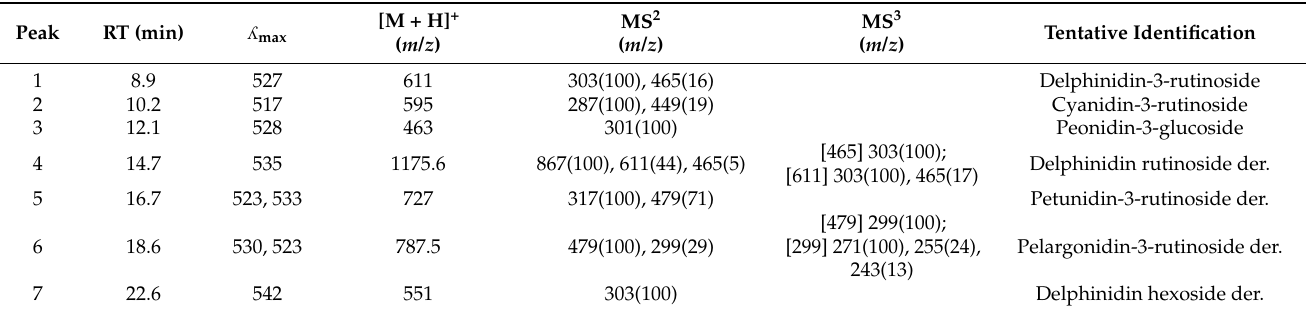
Table 2. Tentative identification of anthocyanins from Slovenian populations of Phyteuma , indicating molecular mass-to-charge ratio ( m / z ) and relative intensity between